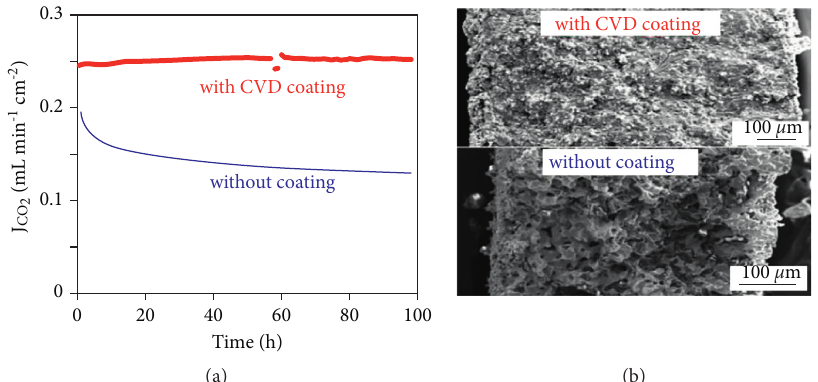
° C. (b) SEM images for samples coated with and